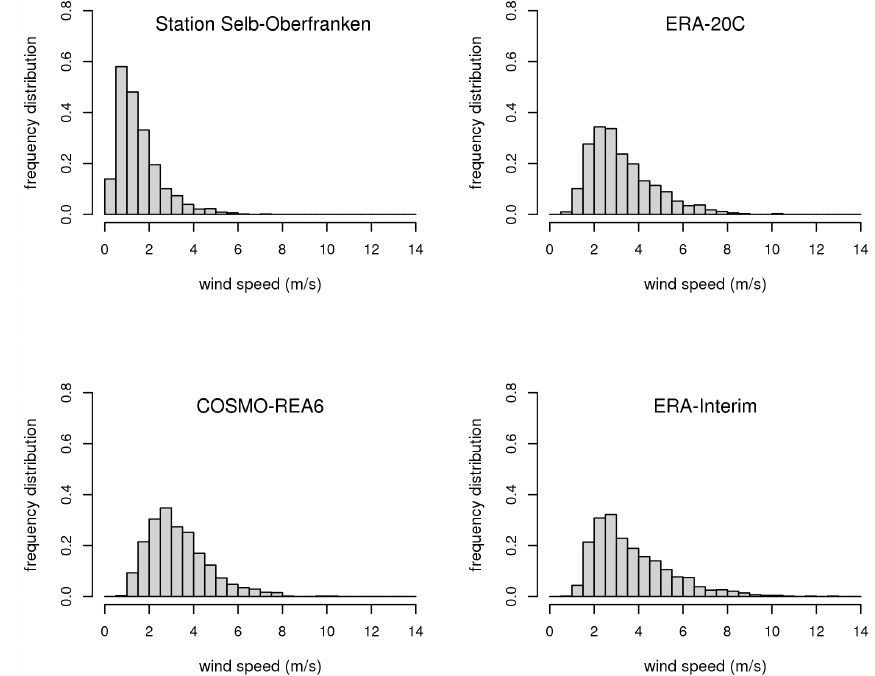
Figure 7. Frequency distribution of daily mean wind speeds in the period 2007 to 2010 for the station Selb-Oberfranken (top left) and matching grid cells of ERA-20C (top right), COSMO-REA6 (bottom left), and ERA-Interim wind fields (bottom